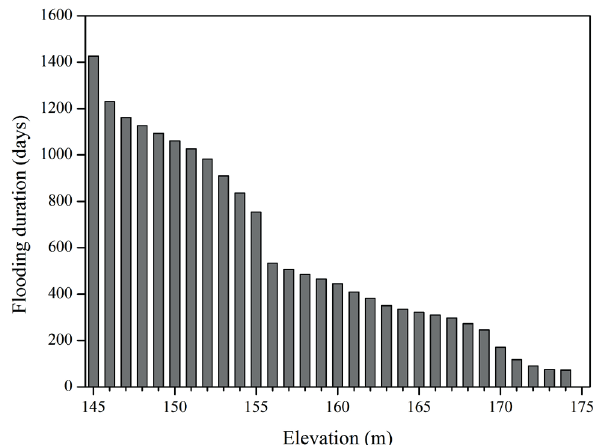
Fig. 5 Inundation duration in relation with elevation in the riparian zone induced by steps of water impoundment and seasonal water level